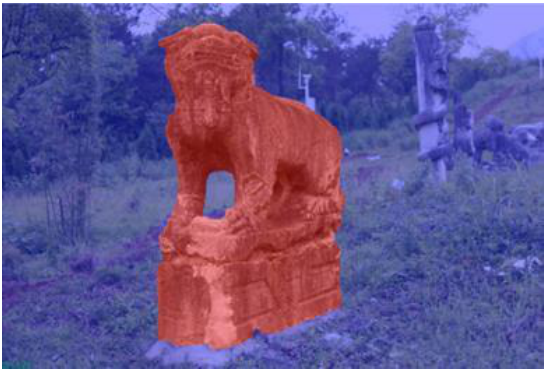
Figure 8. Detected Target Area using One-Cut Algorithm.